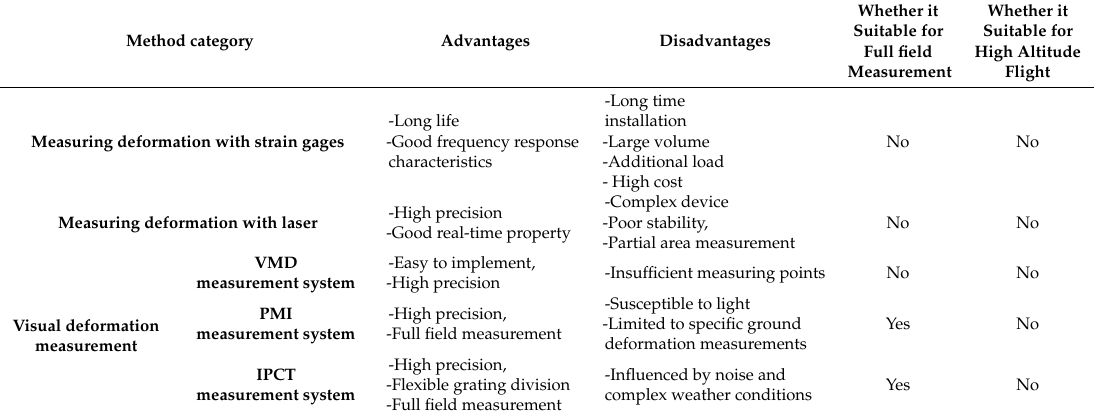
Table 2. Analysis of the characteristics of three measuring